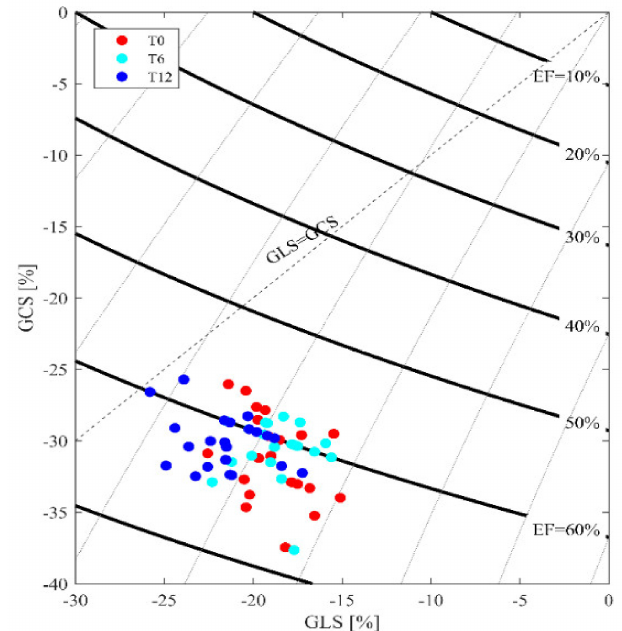
Figure 2. GLS distribution. In the presence of normal and unmodified EF values, increased and more negative GLS values are evident. The cuto ff point of the normal range is within the value of − 15 up to − 17 GLS. The majority of the results are distributed around the − 20 GLS